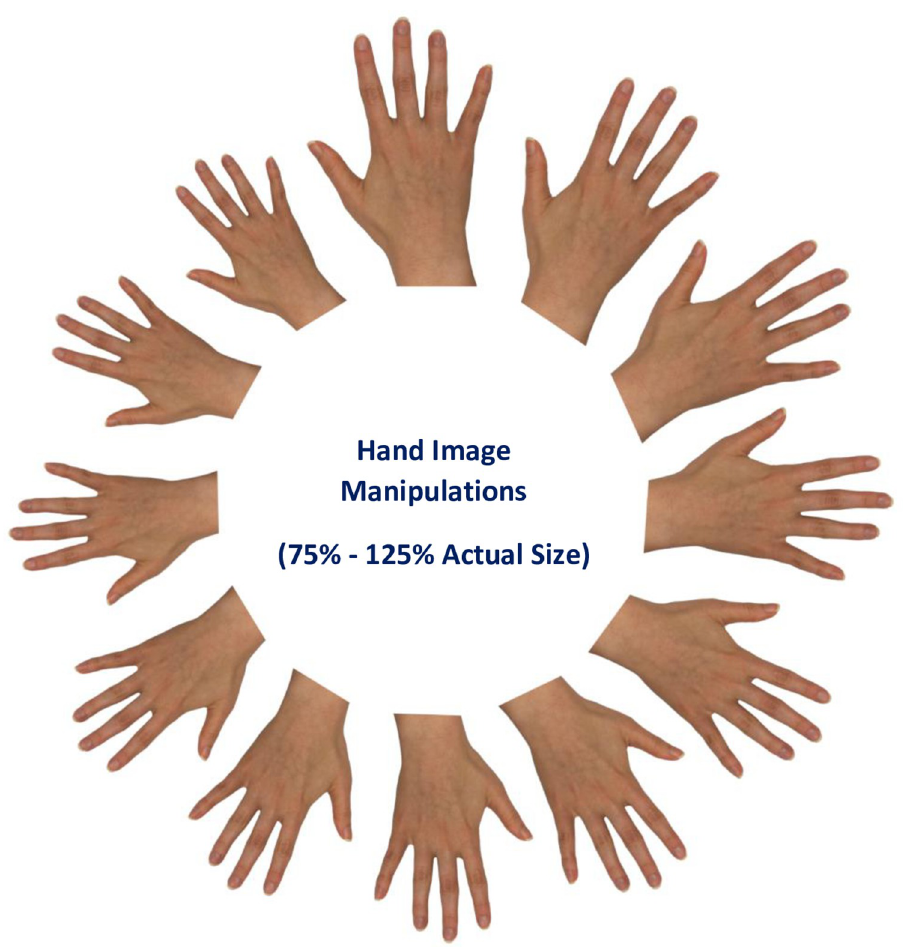
Fig 1. Example of image manipulations of study participants’ non-dominant hand. A high-resolution photograph of each participant’s hand was computer manipulated to provide images between 75% and 125% of actual size. Twelve hand images were presented to the participants in ascending and descending order on a computer screen at a pre- specified distance while their own hands remained hidden. The participants were asked to identify the image that was identical in size to their own